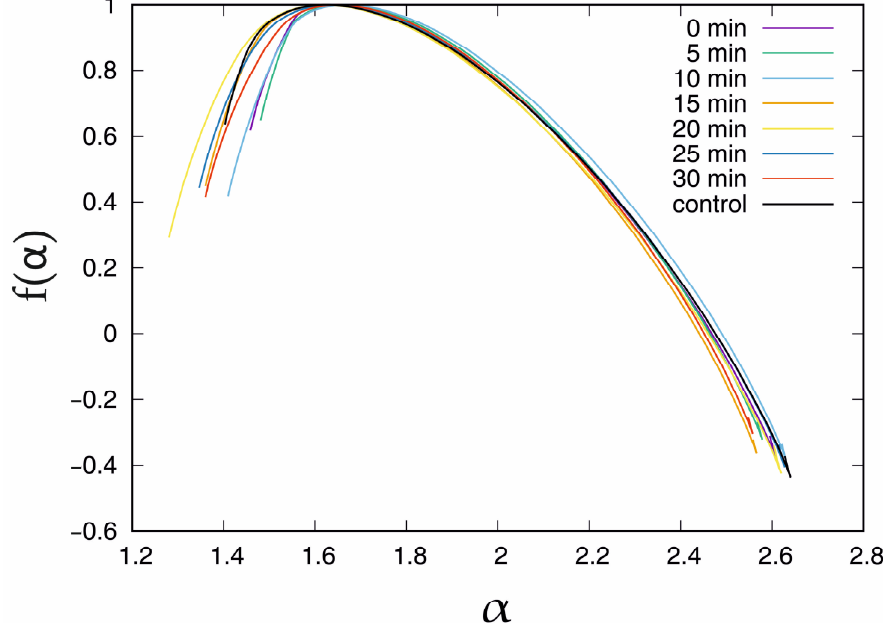
Figure 6. Singularity spectrum f( α ) obtained in the presence of IAA for the chosen incubation times. U = − 100 mV.